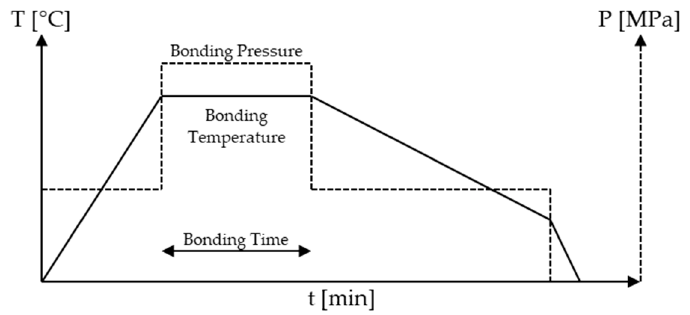
Figure 2. Schematic overview of the reported parameters: bonding pressure, bonding temperature and bonding time in the basic diffusion bonding process.